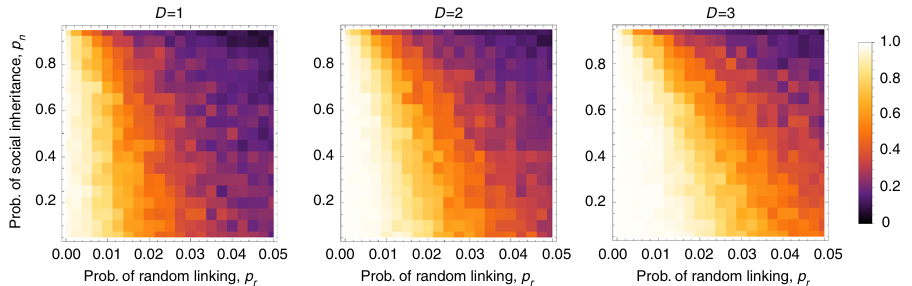
Fig. 2 The effect of synergism on the frequency of cooperation as a function of the probabilities of social inheritance, p n , and random linking, p r . The simulations are run as in Fig. 1. Parameters are N = 100, B = 1, C = 0.5, μ = 0.001, δ = 0.1, C link = 0